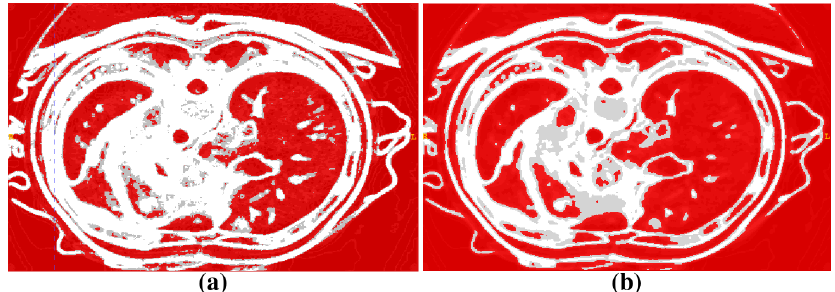
Figure 2. Binary masks obtained from the results of entropy computation: ( a ) 3 × 3 × 3 voxels and ( b ) 5 × 5 × 5